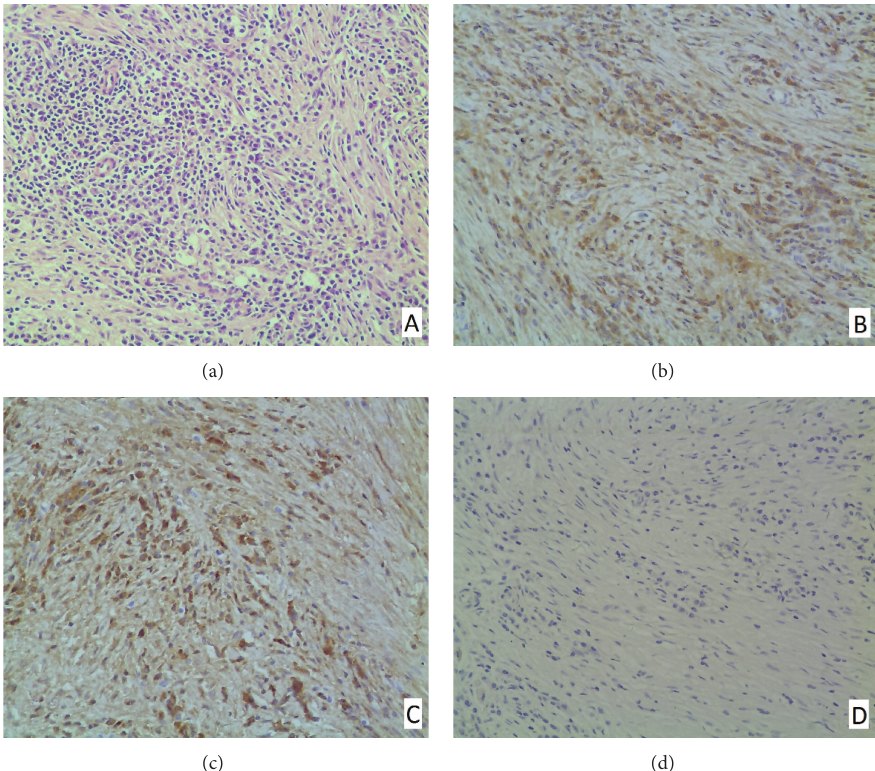
F 4: Histopathologic feature (a) and immunohistochemical staining (b–d) of Case 2. (a) �ymphoplasmacytic in�ltration with predominance of plasma cells and proliferation of myo�broblasts (H��; original